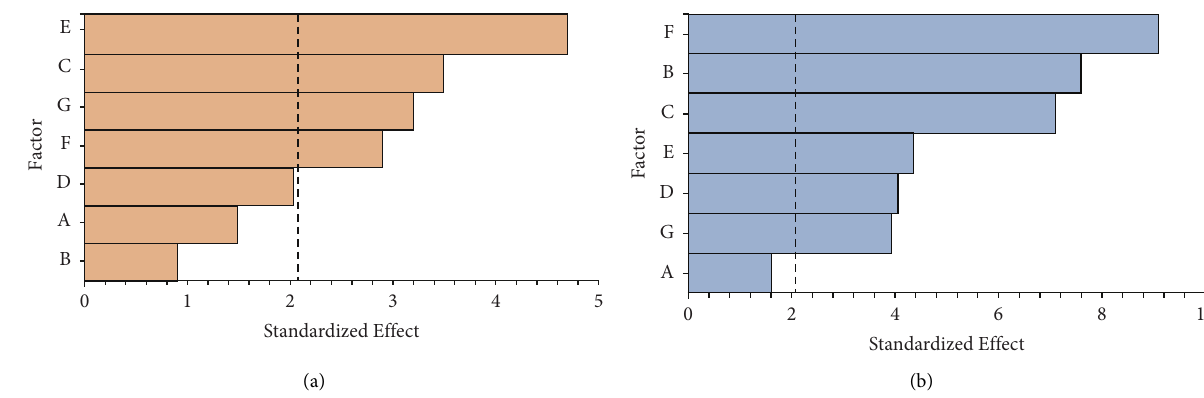
Figure 7: Pareto diagrams of culture conditions infuence for selected strains. (a) strain 208 and (b) strain 290. Te dotted line represents the signifcance limit ( α � 0.05). Temperature (A), agitation rate (B), pH (C), inoculum/volume ratio (D), nitrogen source concentration (E), PVC concentration (F), and PVC particle size (G) are